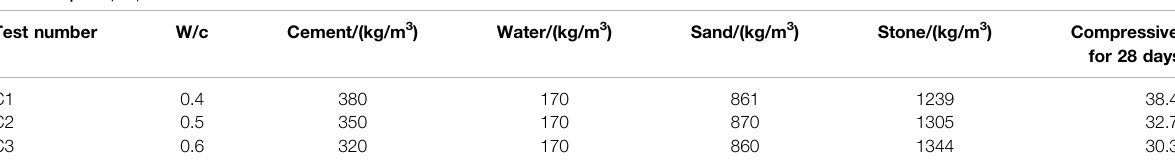
TABLE 4 | Mix proportion of concrete.